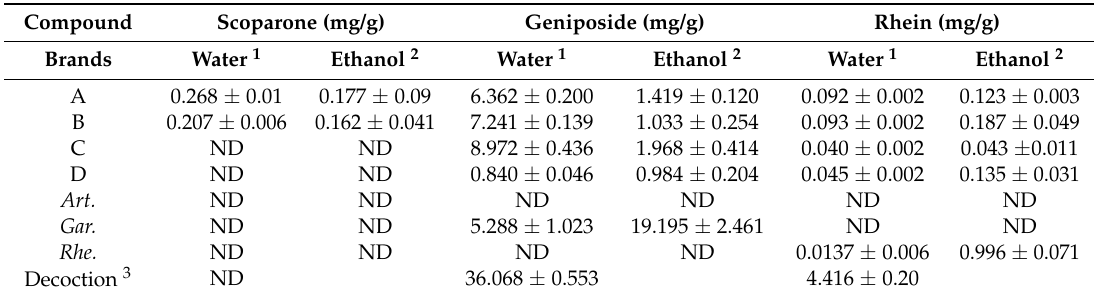
Table 4. Quantitation of bioactive compounds from Yin-Chen-Hao-Tang in different brands of pharmaceutical herbal products and herbal crude